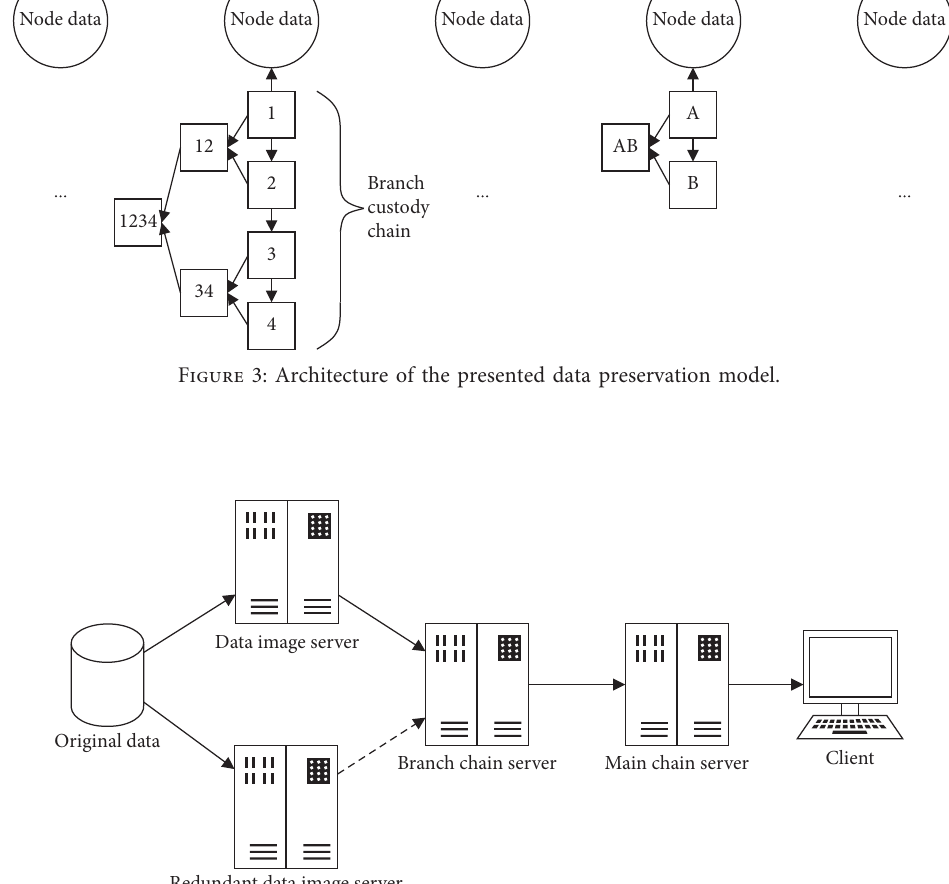
Figure 4: Application scenario for the presented model.